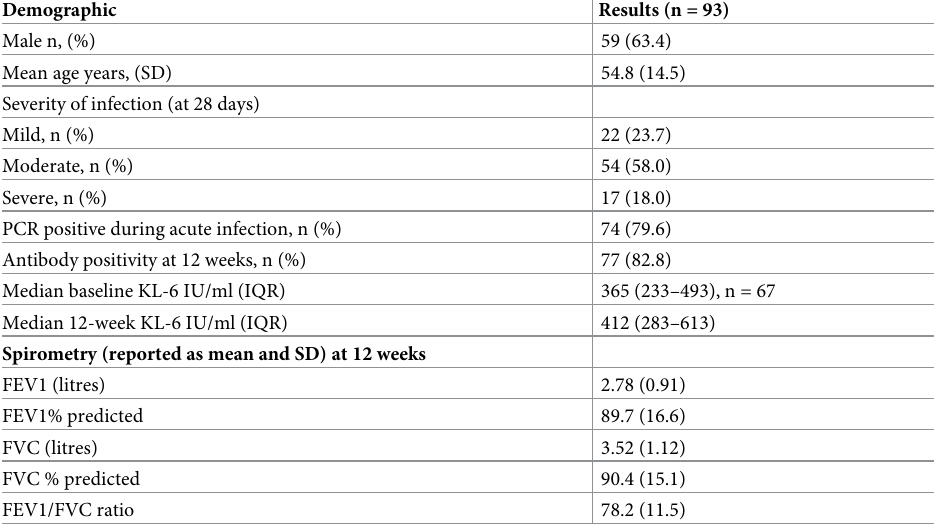
Table 1. Baseline demographics of patients with 12-week serum Krebs von den Lungen-6 (KL-6)